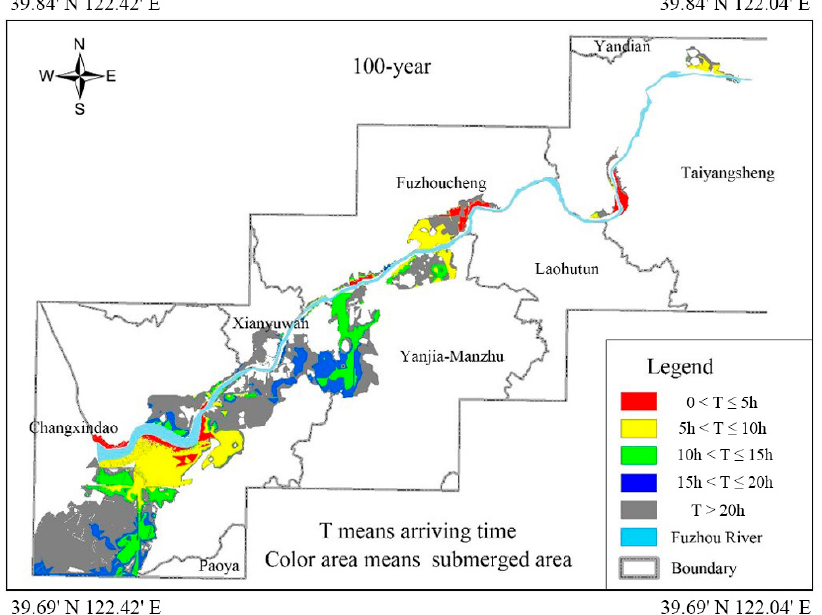
Figure 11. Submerged depth of 50-year return period scenario (Depth in here means maximum depth of the same point during the total flood process).